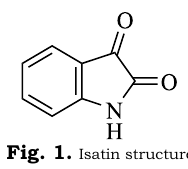
Fig. 1. Isatin structure Erdmann and Laurent discovered isatin for the first time as an indigo oxidation product made using nitric and chromic acids (Erdmann, 1840; Laurent, 1840). It precipitates as orange-red monoclinic prism crystals